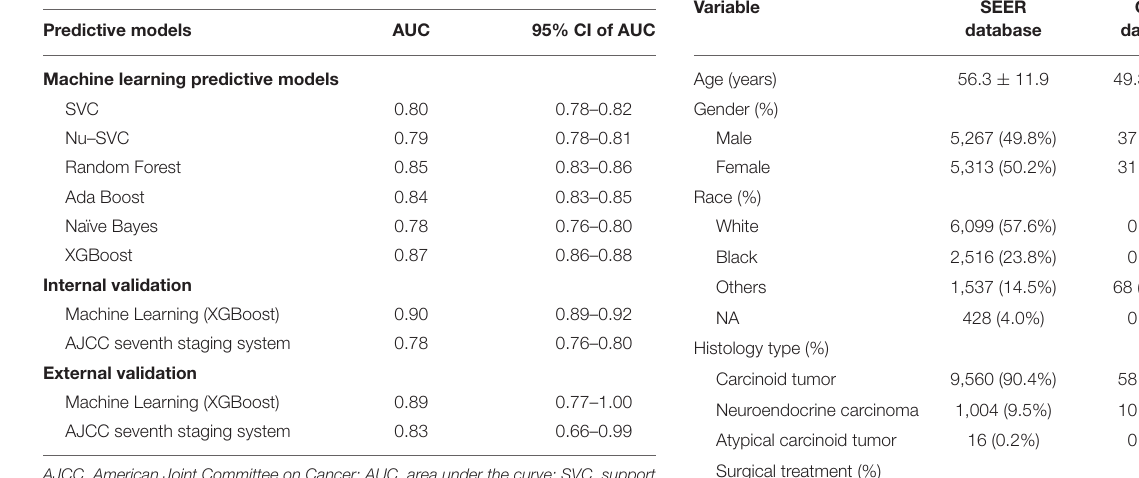
TABLE 6 | Main characteristics of SEER database and China